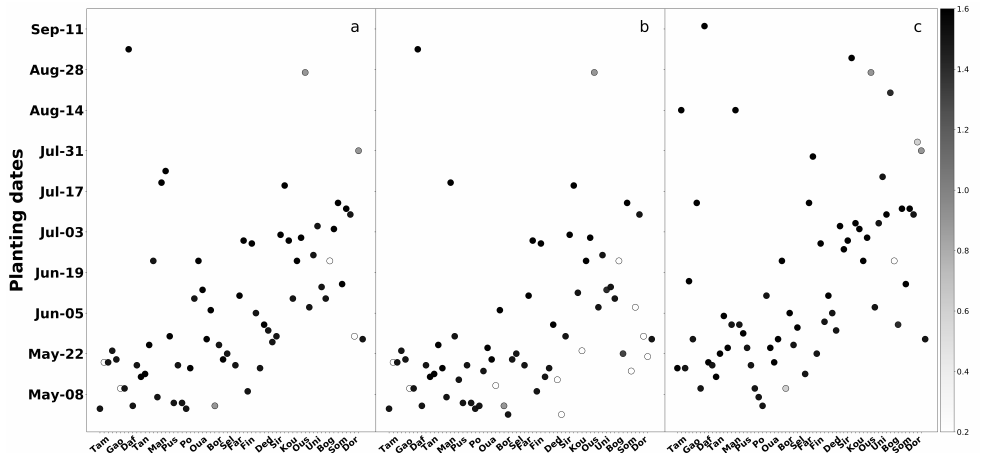
Figure 6. Yield response for sowing dates according to three local onset approaches. The shading of each marker represents the amount of yield [0–1.7 t ha − 1 ] achieved at each location. ( a ) LO20mm, ( b ) FP20mm, ( c )